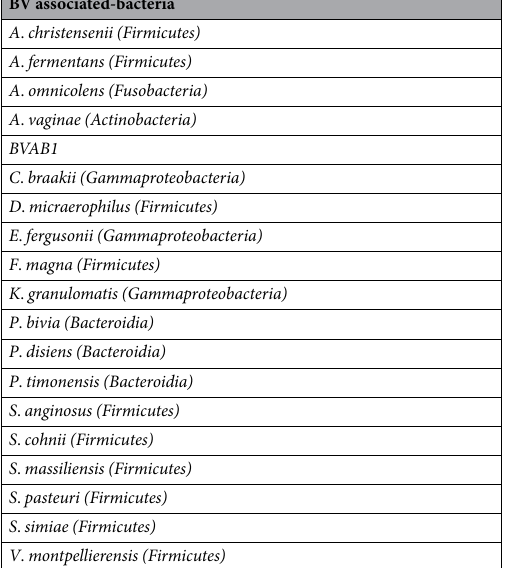
BV associated-bacteria